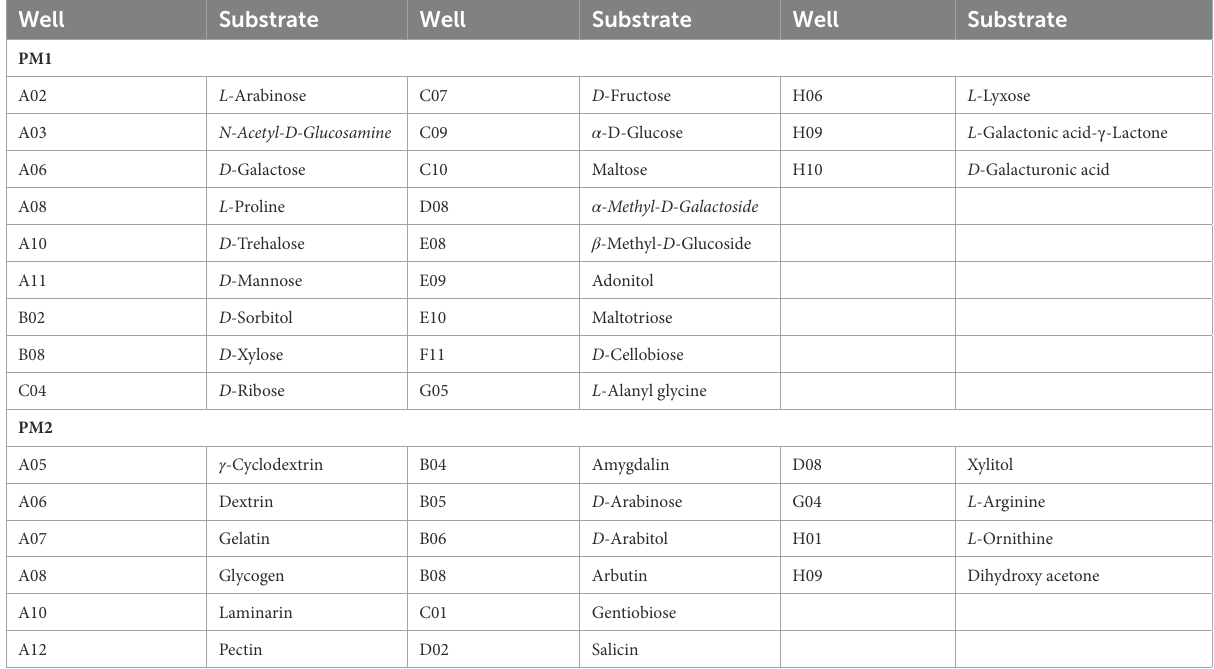
TABLE 1 Substrates in PM 1–2 carbon source Micro plates significantly supported the growth of Rhizopus oryzae.